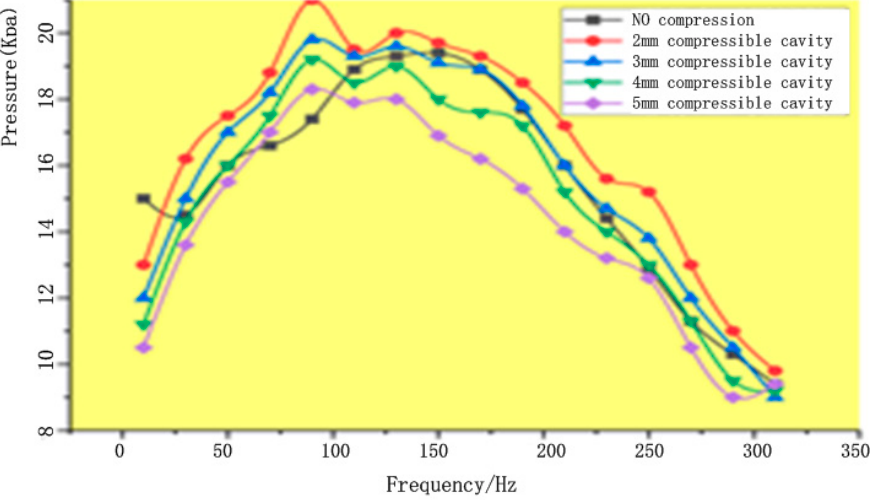
Figure 7. Frequency–pressure contrast